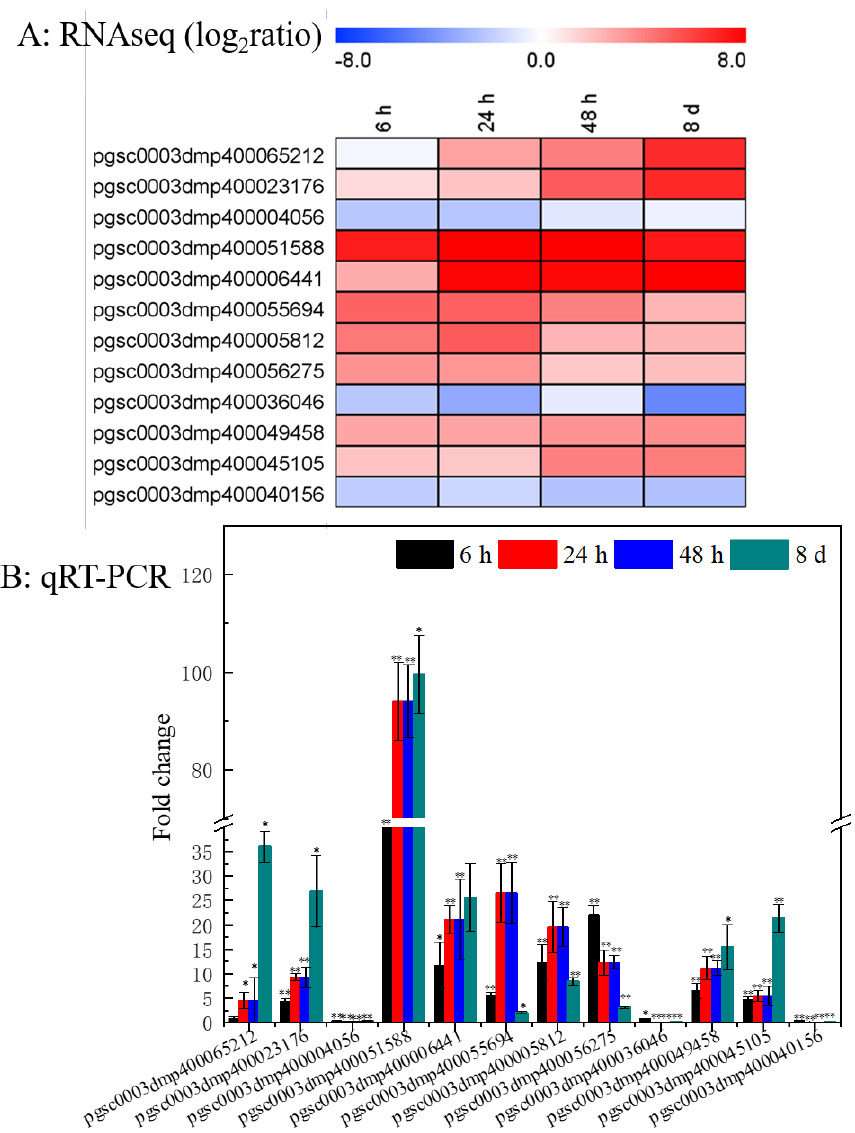
Figure 8. Comparison of RNA-Seq and qRT-PCR analyses for the gene’s expression validation. ( A ): Heatmaps showed transcriptional profiles of candidate DEGs from the enriched Bins. Red indicates genes that are up-regulated, and blue indicates genes that are down-regulated. ( B ): Relative gene expression determined by qRT-PCR. Gene expression was presented as mean value of the light treated tubers as compared to the dark treated tubers for each time point. Error bars represent the range of relative expression (qPCR fold change) calculated by 2 −(∆∆Ct ±SD) ( n = 3). The asterisks indicate a significant difference compared with the group in dark at each time point (* p < 0.05 and ** p < 0.01).